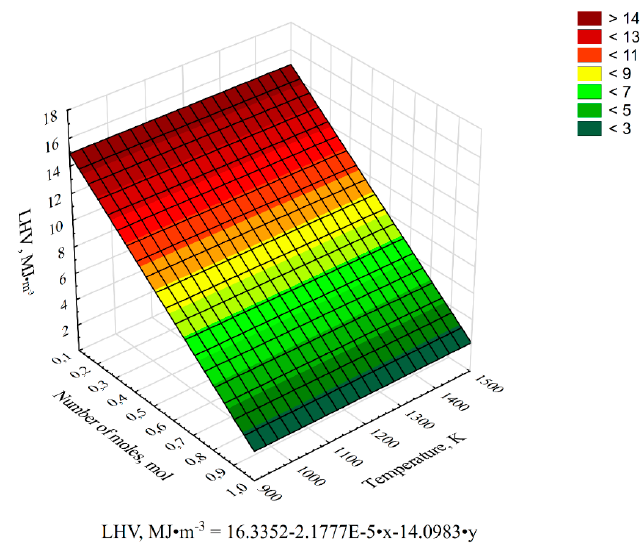
Figure 3. The effect of the number of moles of the gasification agent oxygen (x) and temperature (y) on the heating value ( LHV ) of syngas.